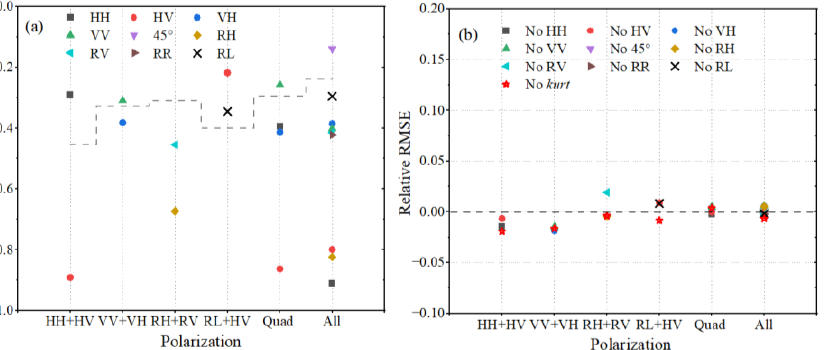
Figure 19. The importance of kurt to SWH retrieval from combined-polarization models. ( a ) The importance ranking of kurt provided by XGBoost models, normalized to the range of 0 – 1. ( b ) The effect of removing kurt on the SWH estimation from different polarized models. The red pentagrams represent the relative RMSE corresponding to the removal of kurt -terms in the combined-polarization models.